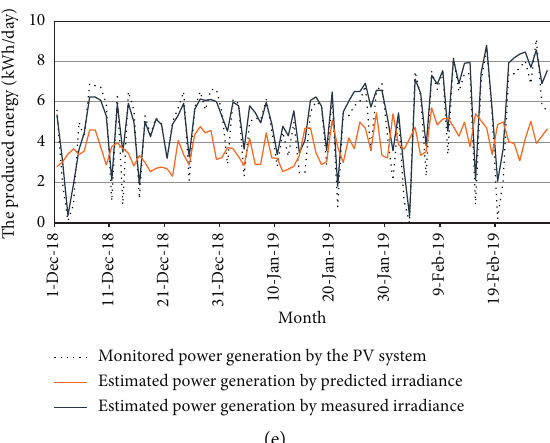
Figure 5: Comparison of the predicted and measured energy production insolations: (a) over one year; (b) spring; (c) summer; (d) fall; (e)